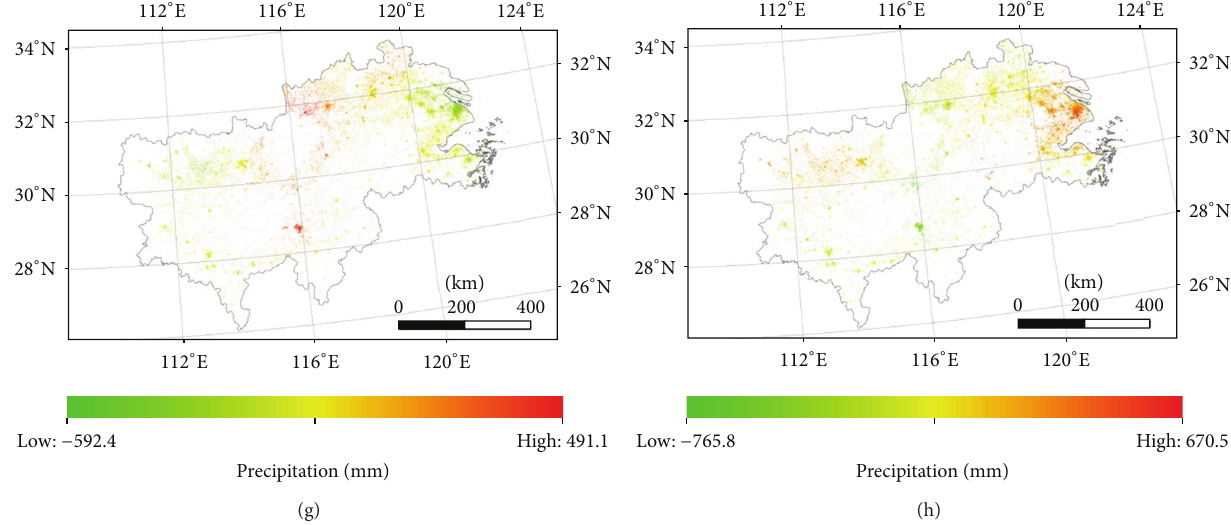
Figure 8: Variations of the temperature and precipitation response to land-use conversion from non-built-up to built-up area in periods